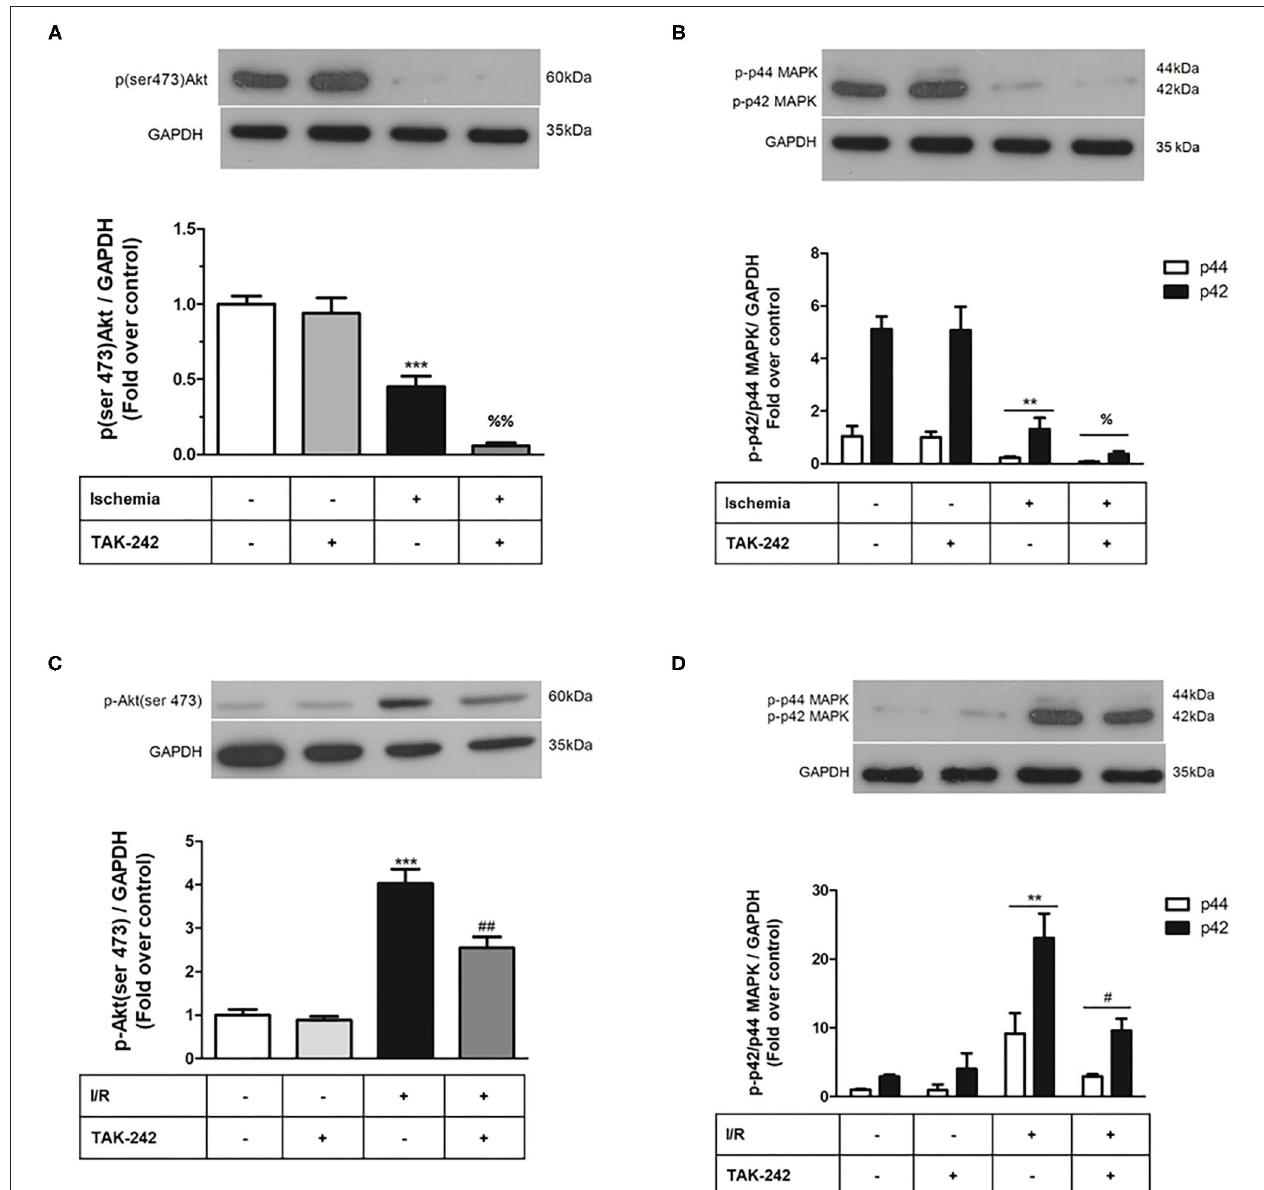
FIGURE 5 | Effect of TLR4 blockade on p-ERK1/2 and p-AKT levels after treatment of cardiac fibroblasts with lipopolysaccharide (LPS) during ischemia and during ischemia and reperfusion. Cardiac fibroblasts were treated with LPS (1 µ g/ml) in the presence of the TAK-242 (4 µ M) inhibitor during the 8h of ischemia (A,B) and during the 8h of ischemia and the 16h of reperfusion (sI/R) (C,D) . The expression levels of p-ERK1/2 and p-AKT were determined by Western blot. GAPDH was used as a loading control (we use the same blot for A,B ). Results are expressed as mean ± SEM of four independent experiments. *** p < 0.001 vs. control; ** p < 0.01 vs. control; % p < 0.05 and %% p < 0.01 vs. ischemia. # p < 0.05 and ## p < 0.01 vs.